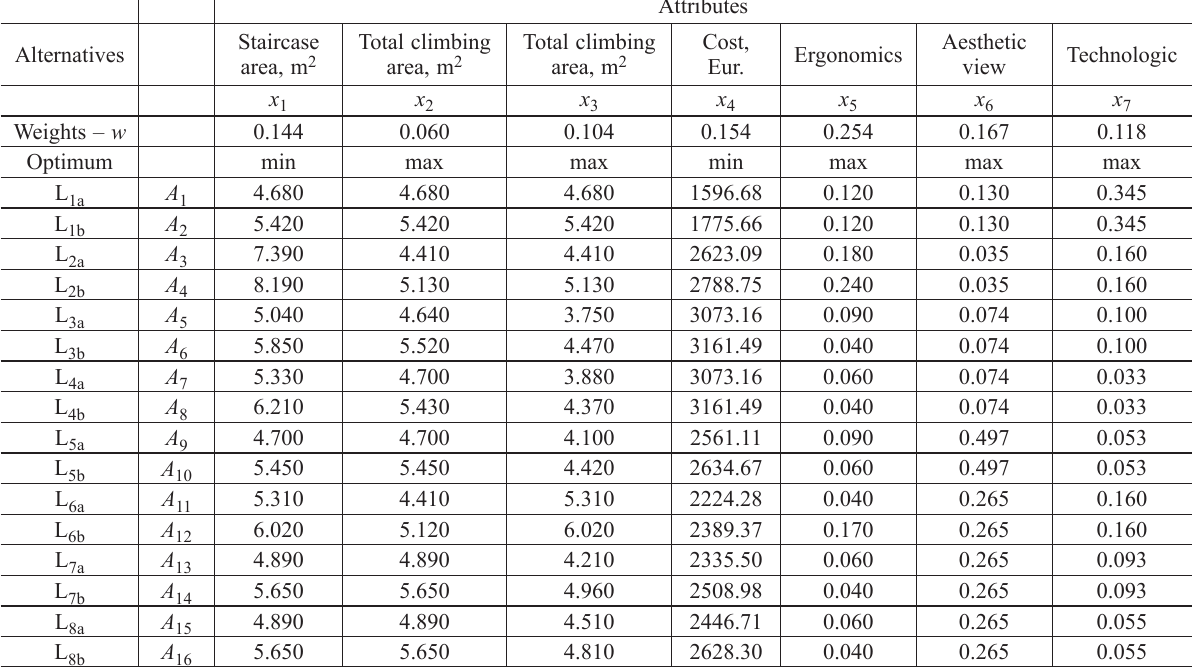
Table 3. Considered stair alternatives